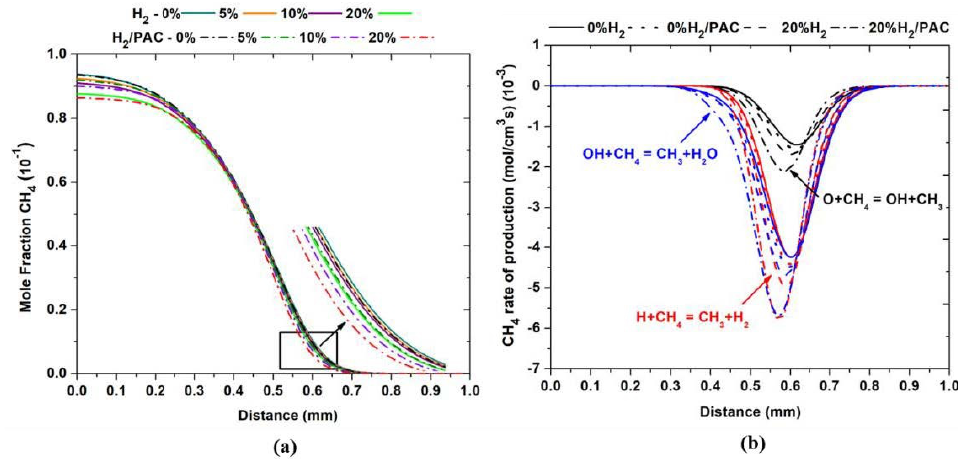
Figure 13. ( a ) Mole fraction profile of CH 4 ( b ) Rate of production of CH 4 with different blends of hydrogen without or with NSPD.